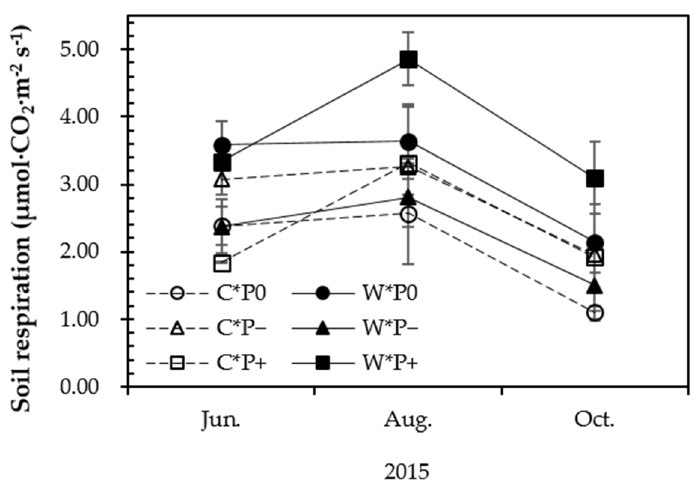
Figure 1. Variations in soil respiration among treatments. Vertical bars indicate the standard error. Treatments: C*P0 = atmospheric temperature control and precipitation control; W*P0 = atmospheric warming and precipitation control; C*P − = atmospheric temperature control and reduced precipitation; W*P − = atmospheric warming and reduced precipitation; C*P+ = atmospheric temperature control and elevated precipitation; and W*P+ = atmospheric warming and elevated precipitation.